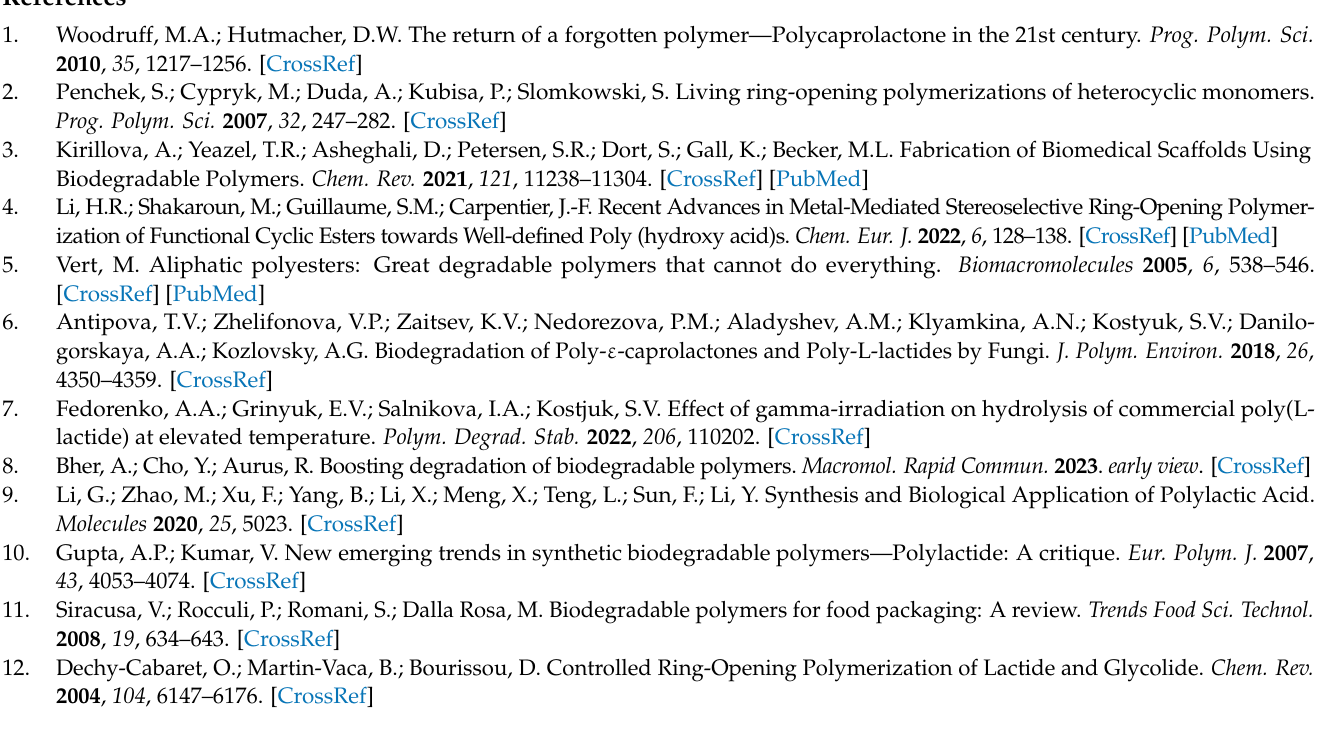
Figure A6. 1 H NMR spectra of poly( ε -caprolactone) synthesized via HPCP-catalyzed ROP of ε -caprolactone with BnOH/HPCP initiating system and purified by re-precipitation in methanol: HPCP: 60.6 mM; [CL]/[BnOH] = 50. Conversion—99%, M n (NMR) = 6900 g mol − 1 , F n = 66%, M n (SEC) = 5050 g mol − 1 ; Ð = 177.